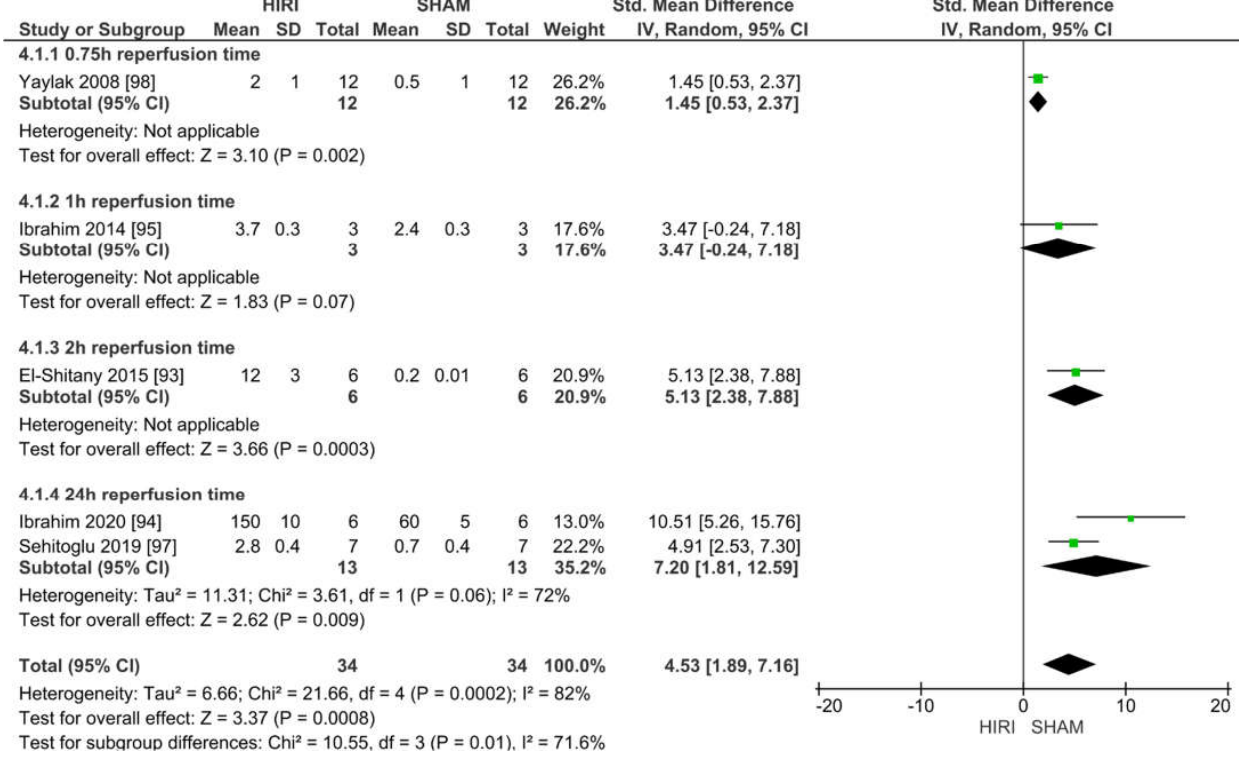
Figure 11. Forest plot of 70% HIRI in mice and 60 min warm ischaemia time grouped by reperfusion time between 1 and 6 h.